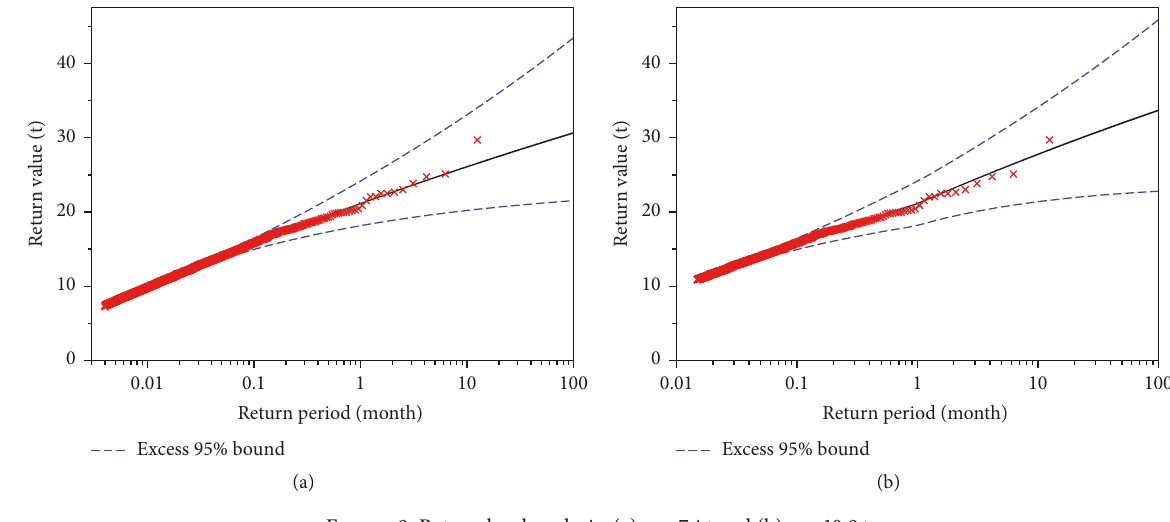
Figure 9: Return level analysis: (a) 𝜇 = 7.4 t and (b) 𝜇 = 10.9